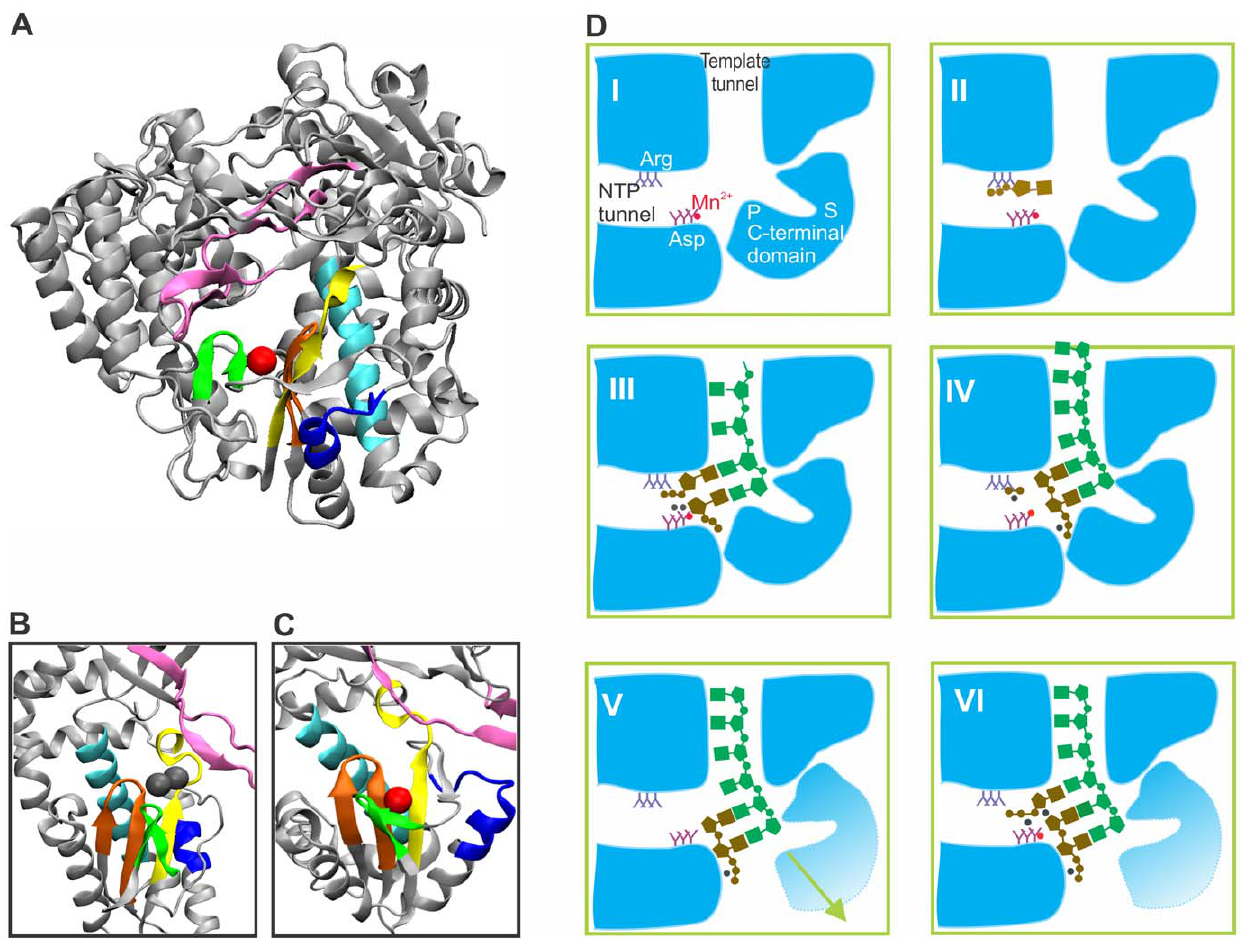
Figure 1. An overview of the vRdRp structure, the catalytic site, and the role of the non-catalytic ion. (A) Conserved motifs in the phage w 6 RdRp (PDBid: 1HHS) and magnified views of the catalytic sites from the RdRps of hepatitis C virus (B) and phage w 6 (C) (PDBids: 2WHO and 1HHS, respectively). Yellow, motif A; cyan, motif B; orange, motif C; blue, motif D; green, motif E; and mauve, motif F. A bound non-catalytic ion is shown as a red sphere (A and C), and the catalytic ions are depicted as gray spheres (B). The structural models were visualized using program VMD 1.8.7 [30]. A schematic model for the initial steps of w 6 RdRp-catalyzed RNA polymerization (D). (I) A cartoon representation of a cross-section of the w 6 RdRp with a bound non-catalytic Mn 2 + ion (PDBid: 1HHS). The template pocket and initiation platform are designated as S and P, respectively. A Mn 2 + ion is presented as a red sphere, and the conserved aspartate residues of the catalytic site are depicted. (II) A preinitiation complex (PDBid: 1HI1). An entering NTP (brown) bound to the arginine/lysine-rich interrogation site. (III) Assembly of the initiation complex (PDBid:1HI0). The catalytic Mg 2 + ions (gray spheres) are located proximal to the catalytic site. The entry of the template (green) and the correct coordination of NTP for catalysis are dependent on the non-catalytic Mn 2 + ion. (IV) Catalysis. A phosphodiester bond is formed between the first two nucleotides of the daughter strand (brown). Pyrophosphate together with bound Mg 2 + diffuse from the catalytic site (PDBid:1UVK). The second catalytic Mg 2 + remains bound to the 5 9 - triphosphate group of the daughter strand. (V) Structural changes in the C-terminal domain allow the exit of the dsRNA product from the catalytic site. The non-catalytic ion is lost from its position (PDBid: 4A8S). (VI) Subsequent catalytic steps in elongation. The model is based on data presented in references